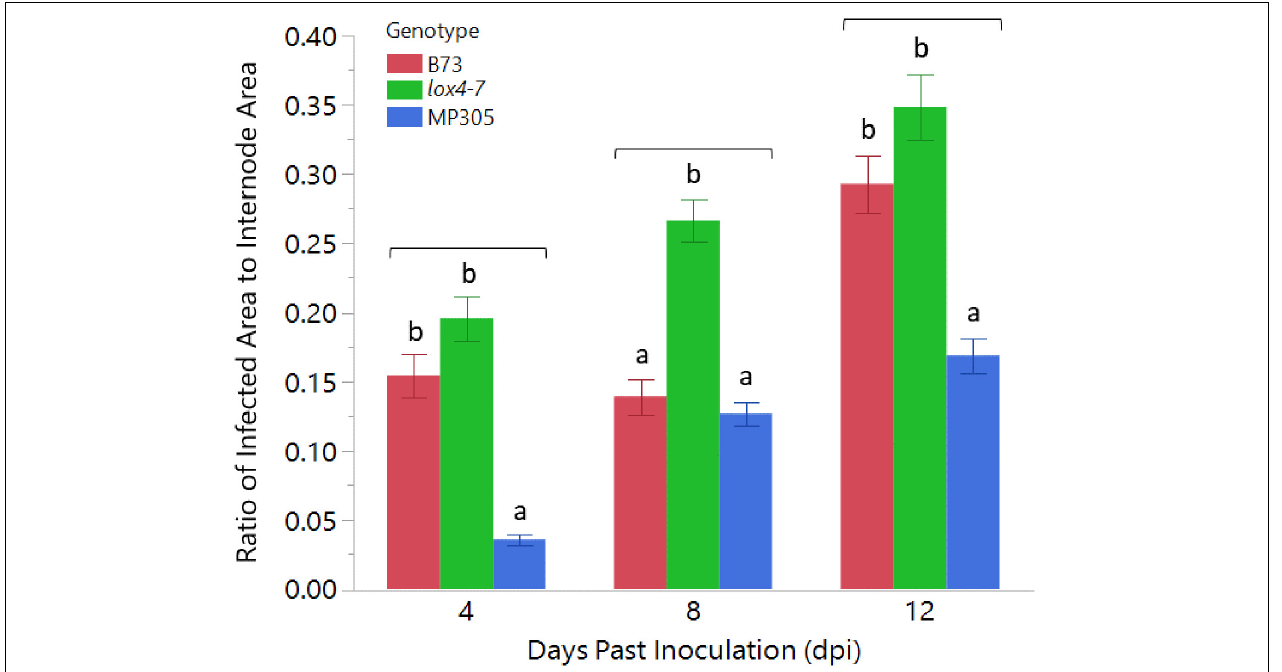
FIGURE 1 | Anthracnose stalk rot progression in wild type B73, lox4-7 , and MP305 maize in greenhouse trial. lox4-7 was significantly more susceptible, as expected, than WT B73 at 8 and 12 dpi, and MP305 displayed significant resistance to lesion development at all time points. Bars indicate ratios of surface areas of Colletotrichum graminicola -infected lesions to areas of each respective internode at 4-, 8-, and 12-days post inoculation (Mean ± SE; different letters indicate significant differences between means within the same time point, determined by Tukey’s HSD, p < 0.05).